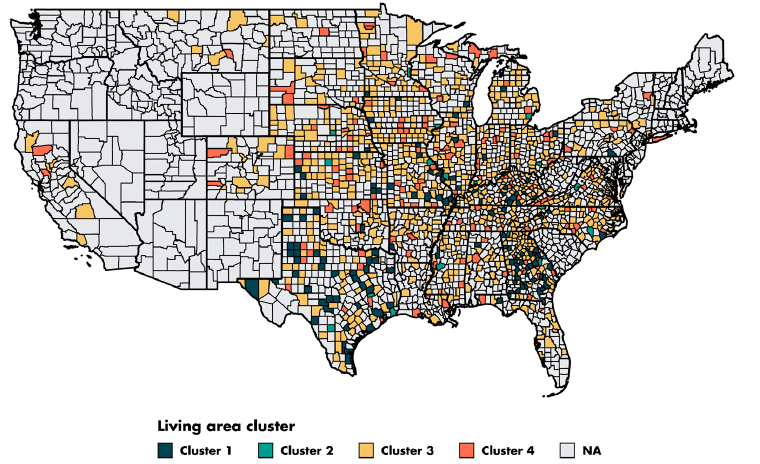
Figure 5. Map of the county clusters in the United States. Of the 3143 counties in the United States, 609 are represented in the ovarian cancer SEER. We excluded two counties located in Alaska due to a lack of data.